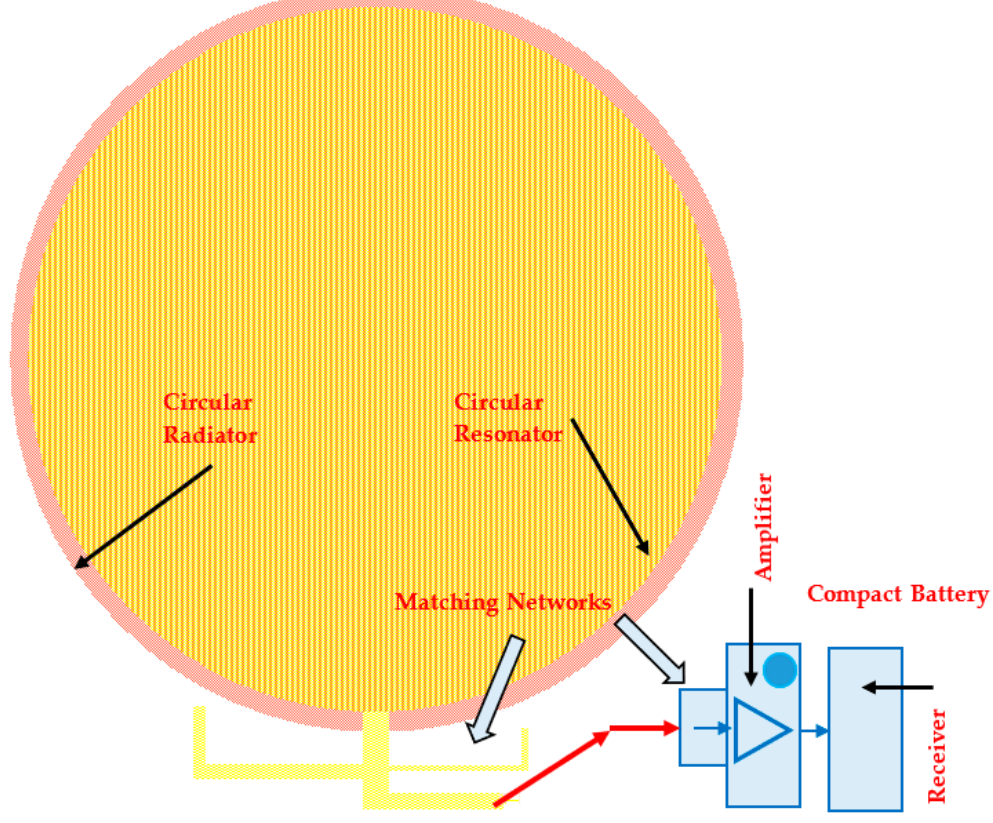
Figure 15. Active Receiving Compact Double Layer Circular Patch Antennas.